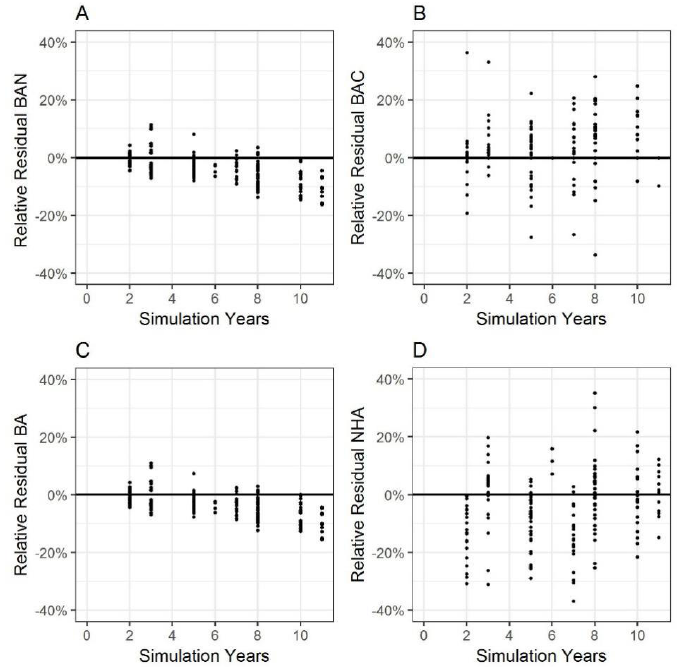
Figure 4. Relative residuals for different simulation years in projections of ( A ) basal area of Nothofagus species (BAN, Equation (9)); ( B ) basal area of companion species (BAC, Equation (10)); ( C ) total basal area, BA = BAN + BAC; and ( D ) number of trees per hectare (NHA, Equation (3)) using the PP data as validation.